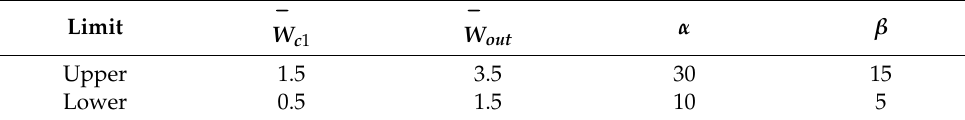
Figure 1. Schematics for improved flow-focusing microchannel. Table 1. Design variables and design space.